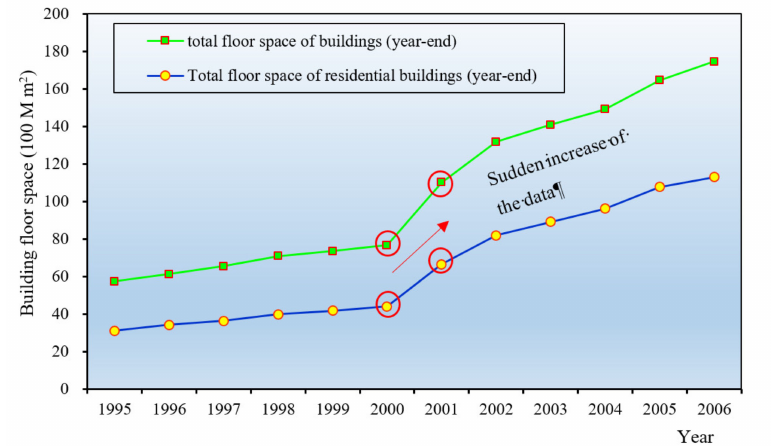
Figure 1. The total floor space of residential buildings (TBFS) and the TRBFS from 1995 to 2006.